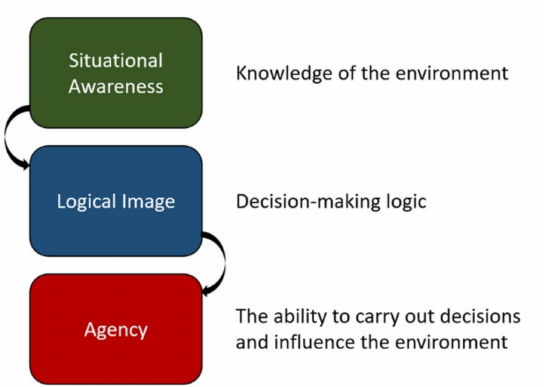
Figure 1. The three intelligent activities that make up the Intelligence Transfer Model